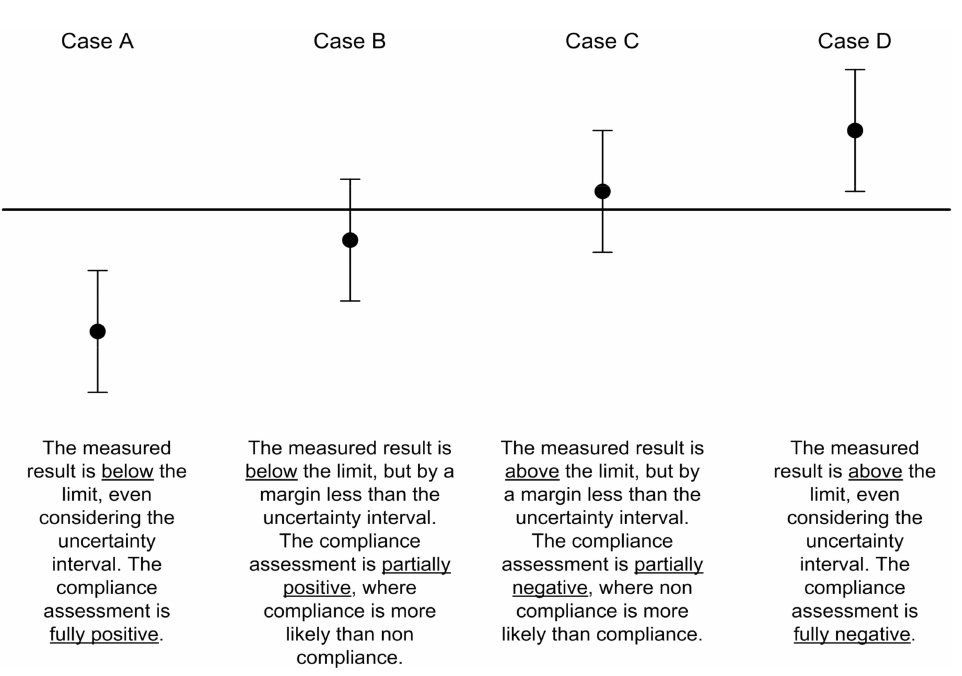
Figure 7. Comparison of measured value and limit including